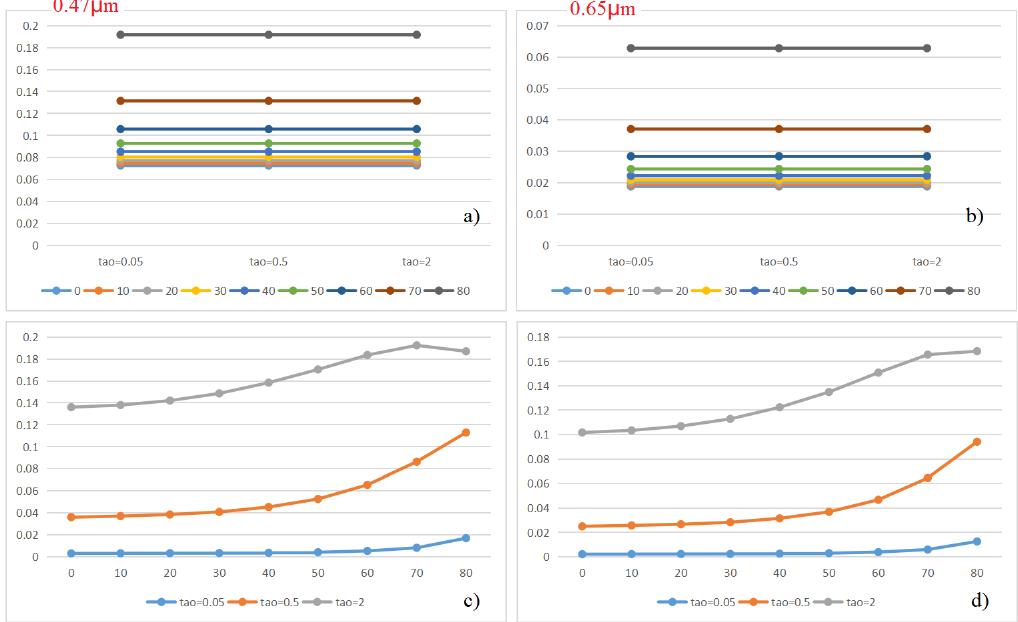
Figure 3. Variation of the apparent reflectance at two bands from molecule scattering ( a , b ) and aerosol scattering ( c , d ) as simulated by 6SV; the left panel stands for the variation in blue the channel, and the right one denotes in the red channel. Different colors in sub-panels ( a , b ) represent satellite zenith angles, and those in sub-panels ( c , d ) represent aerosol optical thickness.